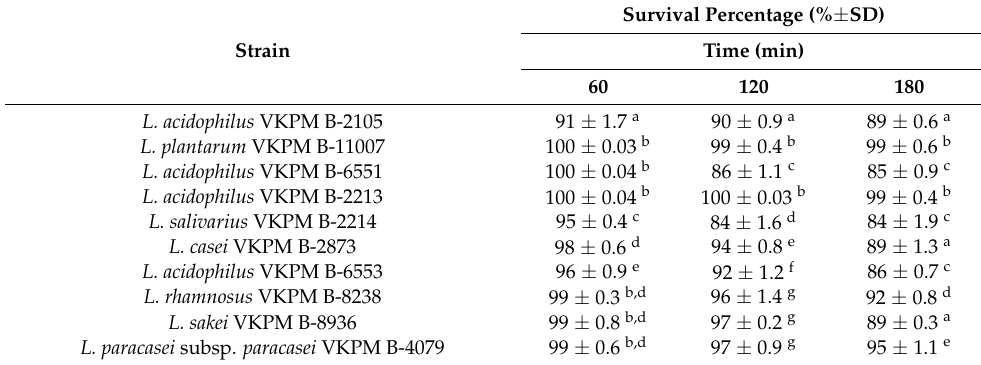
Table 5. Tolerance of Lactobacillus strains to simulated duodenal environment (pH 6.0).